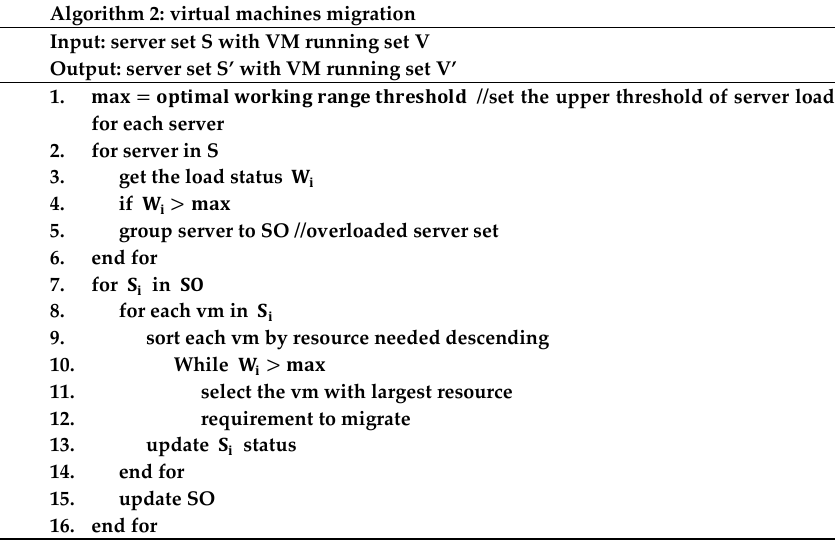
Algorithm 2: virtual machines migration